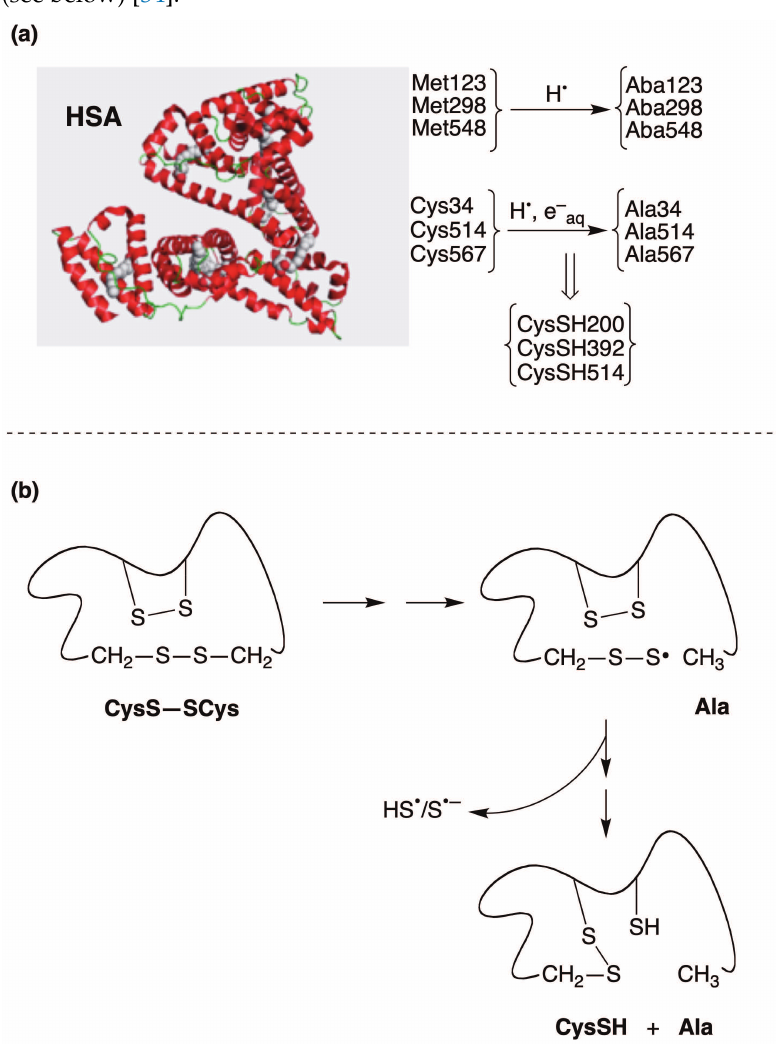
Figure 1. Human serum albumin (HSA): ( a ) Methionine (Met) and Cysteine (CysS–SCys) residues are modified by attack of reductive transient species (H-atoms or hydrated electrons), yielding α -aminobutyric acid (Aba) and alanine (Ala)/CysSH, respectively; ( b ) Proposed mechanism for the formation of alanine residues (cf. Scheme 1b) and CysSH derived from a scrambling event with other